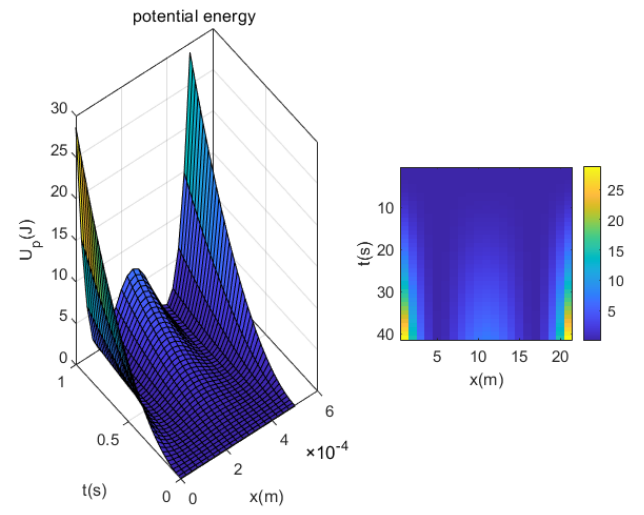
Figure 7. Potential energy change of the viscoelastic micro-beam. See Table A1 for explanations of professional